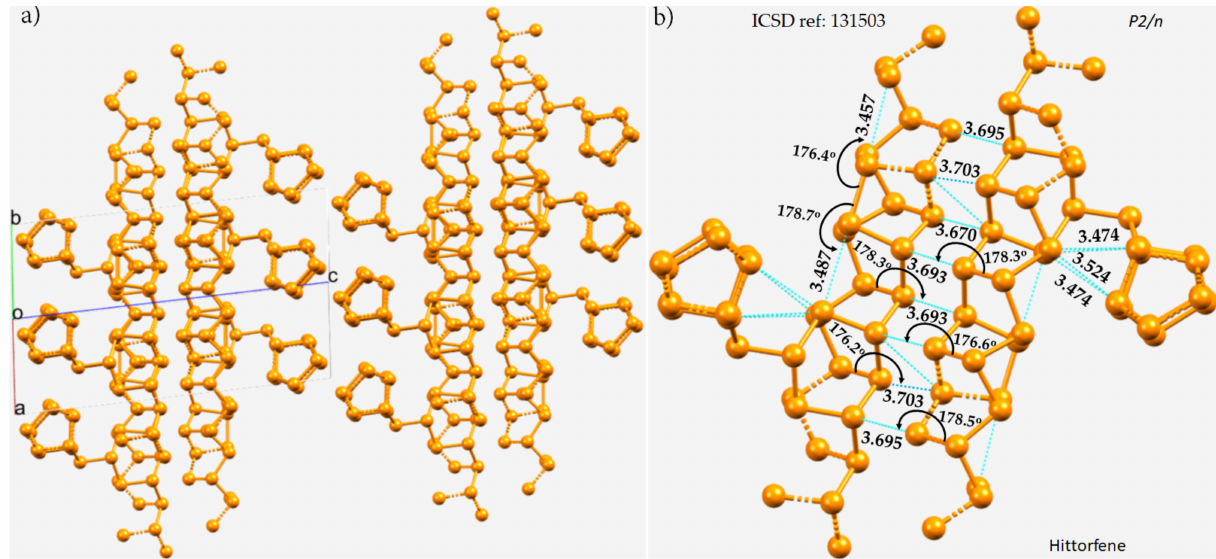
Figure 2. ( a ) The 2 × 2 × 2 supercell structure of Hittorfene (violet phosphorus). ( b ) The nature of P ··· P bonding interactions between the layers, and within the same layer, of the crystal. Selected bond distances and bond angles are in Å and degrees, respectively. Dotted lines in cyan represent an interaction between a pair of P atoms. P atoms in the ball-and-stick models are colored